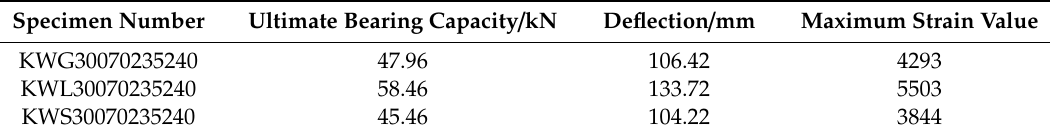
Table 4. Ultimate bearing capacity, deflection, and strain.